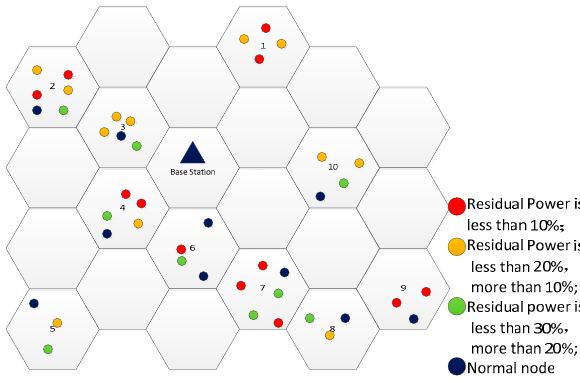
Figure 1. Sample diagram of prior charging clusters.